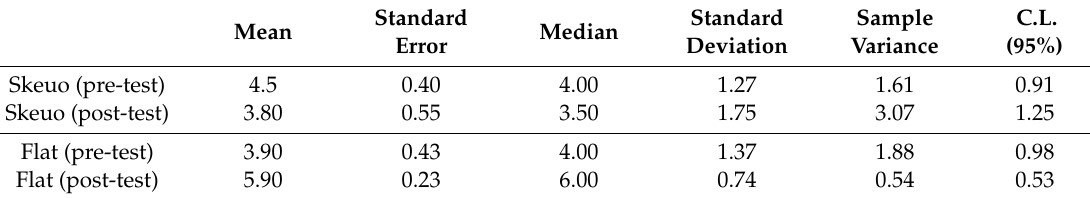
Table 12. Expectation (pre-test) and experience (post-test) ratings on scenario execution difficulty.